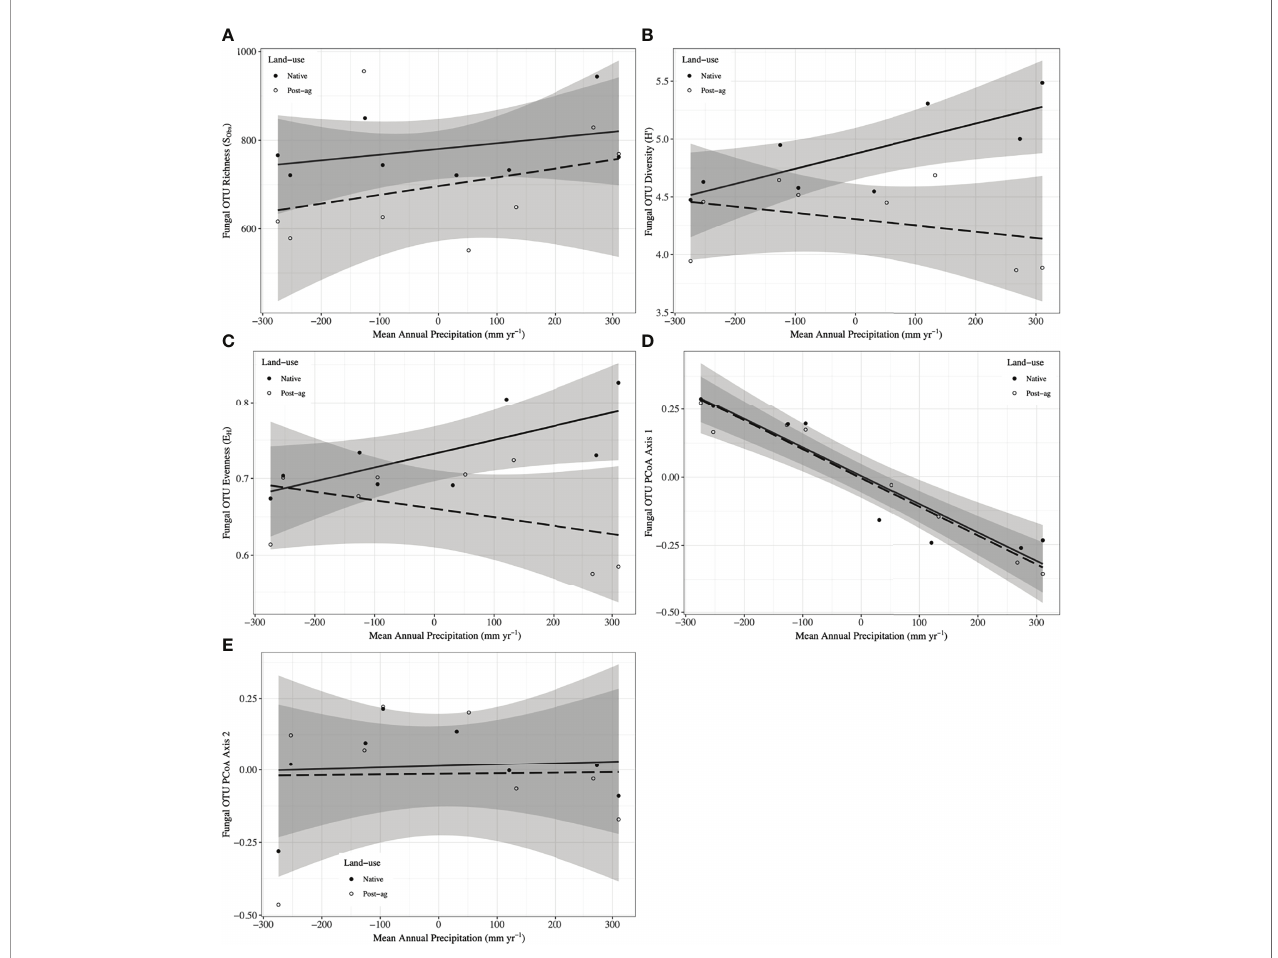
FIGURE 3 | Fungal Operational Taxonomic Unit (OTU) responses to mean annual precipitation (MAP) normalized around the mean precipitation (730.01 mm yr -1 ) in native prairie remnants (solid line and fi lled symbols) and post-agricultural sites (dashed line and open symbols). Models predict observed species richness (S Obs ) (A) , Shannon diversity (H ’ ) (B) , evenness (E H ) (C) , PCoA Axis 1 scores (D) , PCoA Axis 2 scores (E) . The shaded areas represent 95% con fi dence intervals around the model